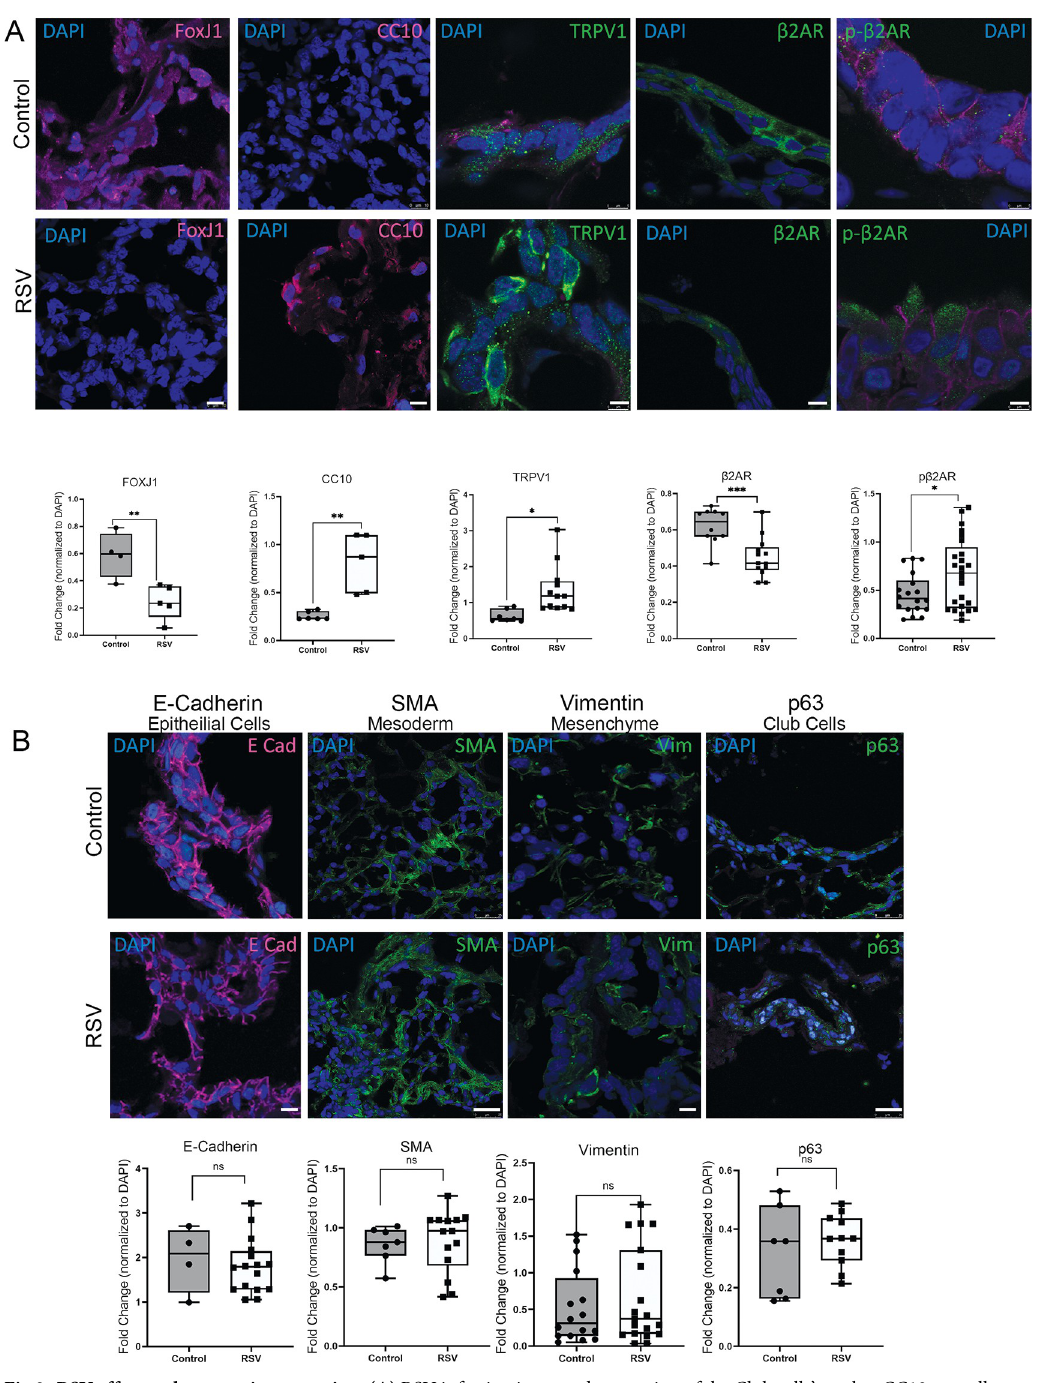
Fig 3. RSV effect on key protein expression. (A) RSV infection increased expression of the Club cells’ marker CC10, as well as the transient receptor potential vanilloid 1 (TRPV 1 ) calcium channel in mesenchymal cells. In contrast, the expression of ciliagenesis marker FoxJ1 was inhibited. While the expression of β 2ARs was reduced, its phosphorylated fraction increased after RSV infection. (B) RSV infection did not affect the total expression of the epithelial cells’ marker E-cadherin, smooth muscle cells’ marker actin, mesenchymal cells’ marker vimentin, and basal cells’ marker p63. Graphs below are densitometry of images of a minimum 5 organoids for each control or RSV for each stain.